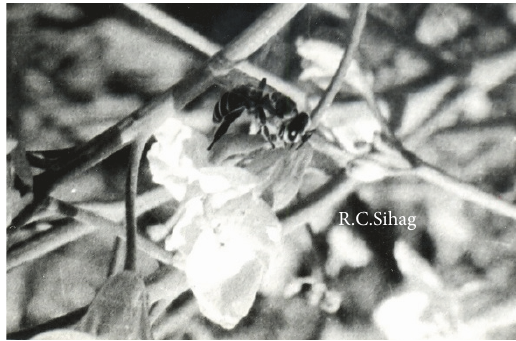
Figure 1: A forager of the dwarf honeybee ( Apis florea F.) thieving nectar from the side or base of the flower of cauliflower ( Brassica oleracea L. var.